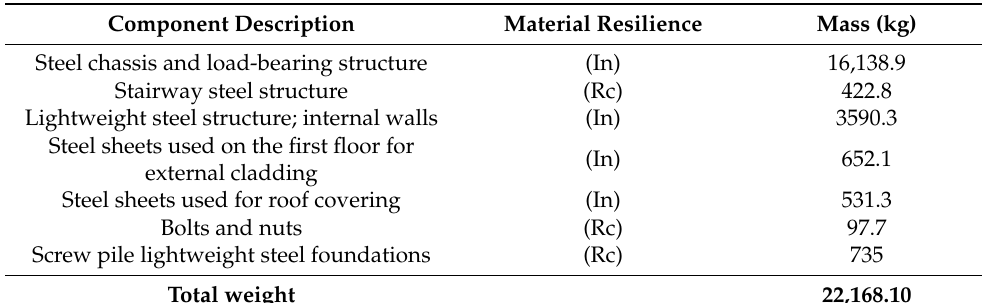
Table 1. Steel components used in the L3 case study by mass (kg) and their resilience metric. In = reusable infinite times, Rc = recyclable. Component